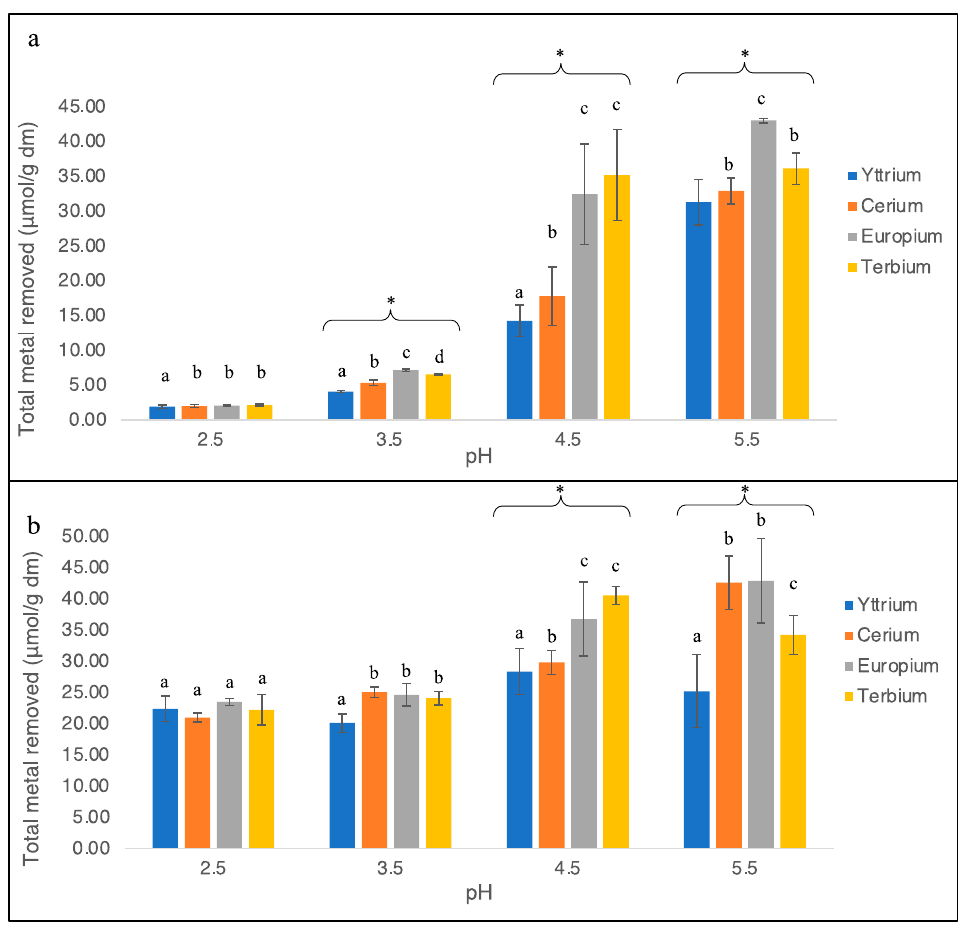
Figure 1. Metal removed from the single-metal aqueous solutions by G. sulphuraria , strains SAG 107.79 ( a ) and ACUF 427 ( b ). Data were divided based on the pH of the solutions. Different letters in the same experiment indicate a significant difference, p < 0.05; Symbol (*) indicates a p < 0.05 significant difference compared to the pH 2.5.